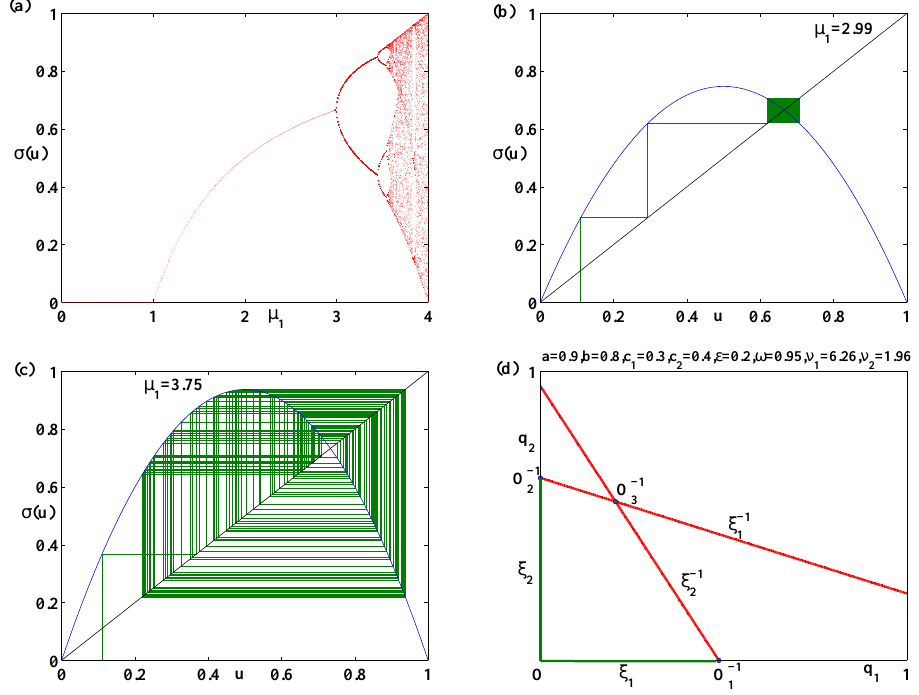
O(d) Figure 2. ( a ) The 1D bifurcation diagram of map σ ( u ) with respect to µ 1 . Iterations of σ ( u ) at ( b ) µ = 2.99 and ( c ) µ = 3.75. ( d ) The lines ξ 1 and ξ 2 and their inverses at: a = 0.9, b = 0.8, c 1 = 0.3, c 2 = 0.4, (cid:101) = 0.2, ω = 0.998, ν 1 = 6.26, and ν 2 =